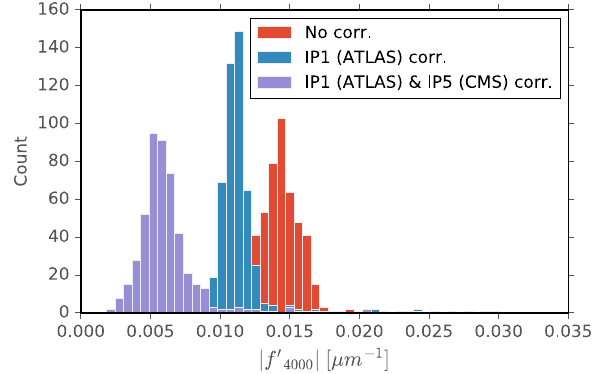
FIG. 12. Histogram of the j f 0 4000 j ac-dipole resonance driving term, related to the 4 Q x resonance, measured in LHC BPMs with and without correction of normal octupole errors in the ATLAS (IR1) and CMS (IR5) insertions.